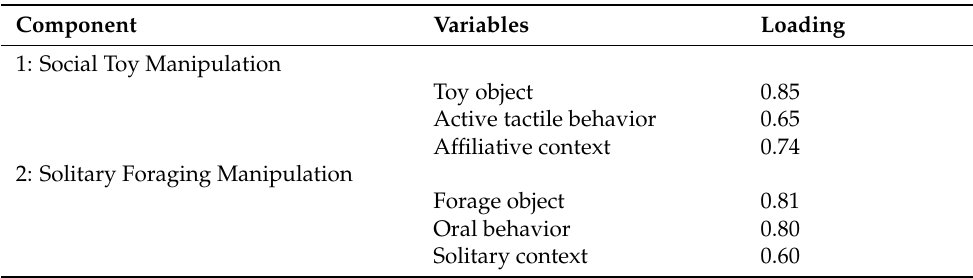
Table 6. Component loadings for enrichment objects, manipulation behaviors, and social contexts ( n = 760 occurrences of enrichment use).